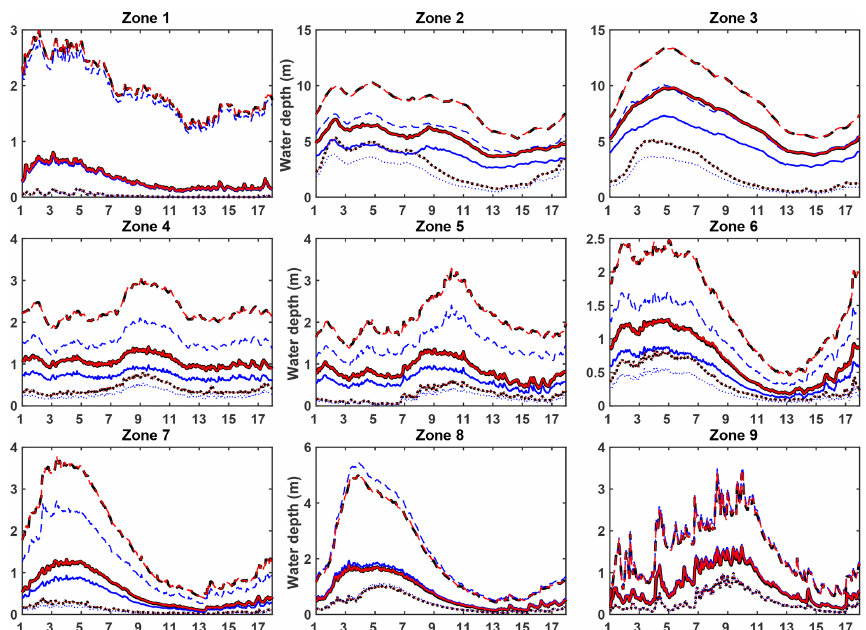
Figure 8. Water depth assimilation results for the PE1 experiment: daily evolution of the ensemble-averaged analysis water depth (red lines) compared to the true water depths (black lines) and the openloop water depths (blue line). For each zone (one per subplot), the median (full line), the first decile (dotted line) and the ninth decile (dashed line) of water depth ensembles over all grid cells in the zone are